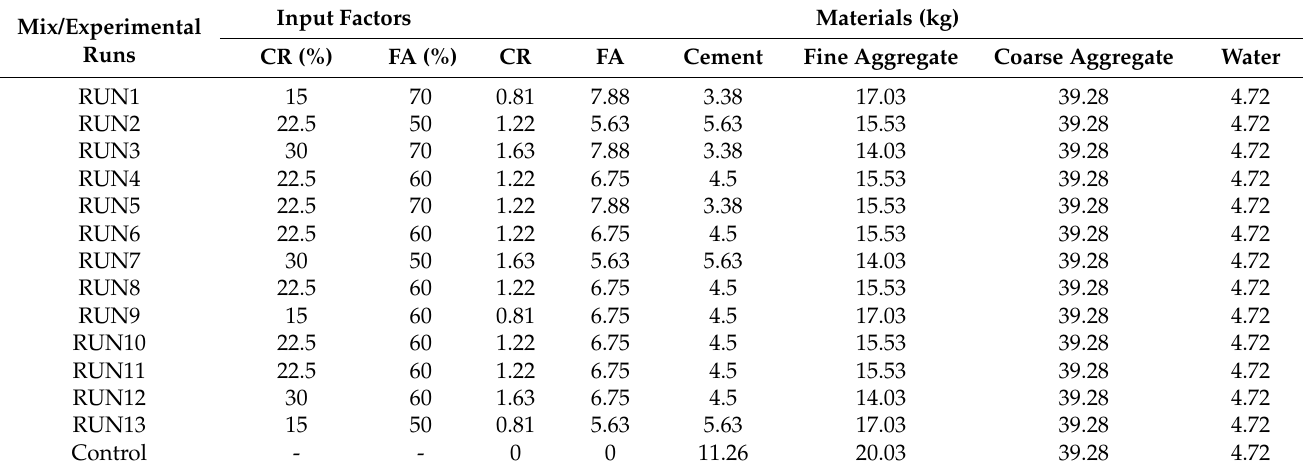
Figure 2. ( a ) Particle size distribution and ( b ) XRD pattern of the FA. Table 2. RSM generated mixes and quantities of materials